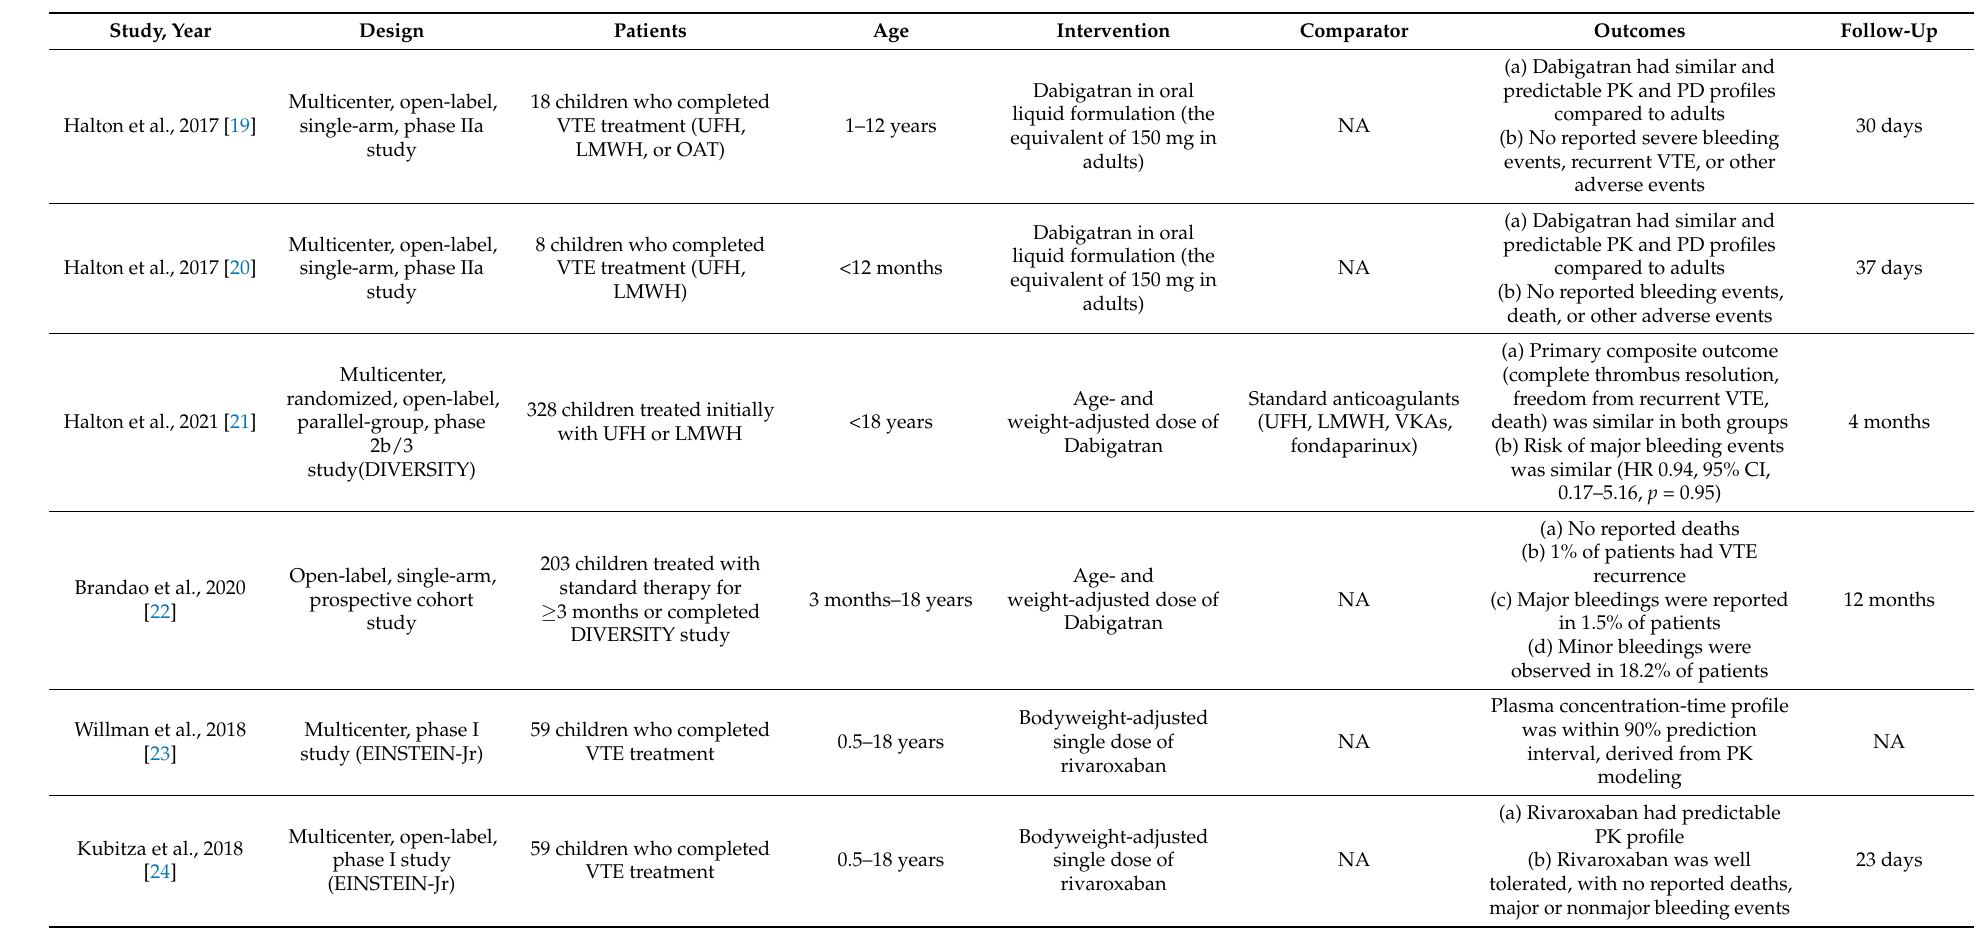
Table 1. Evidence from clinical trials regarding DOAC use in children with